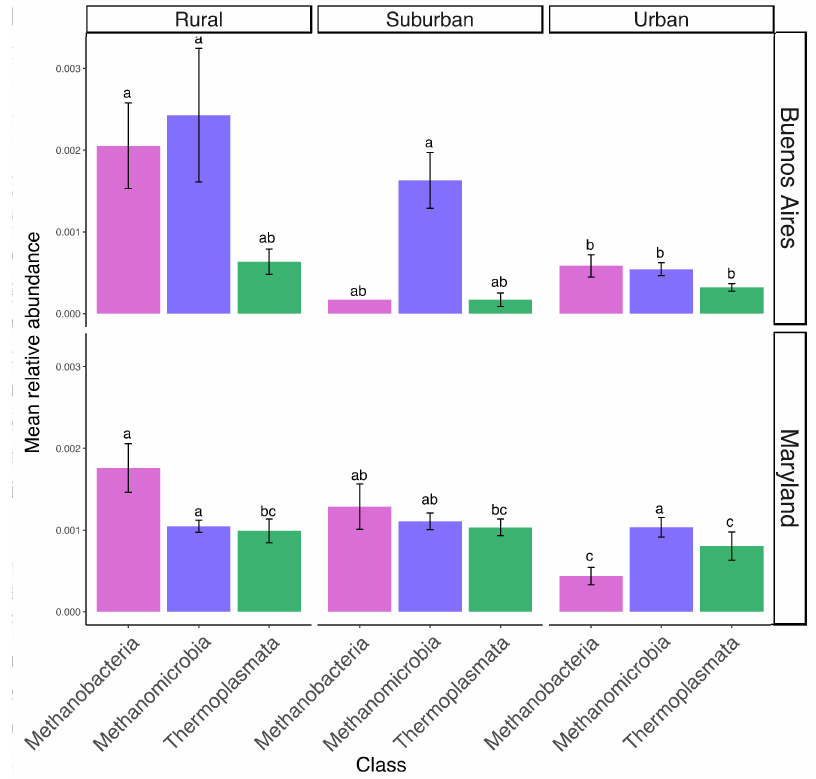
Figure 6. Mean relative abundance of Euryarchaeota classes for Buenos Aires and Washington D.C. in urban, suburban, and rural sites. Bars represent standard errors and different letters indicate significant differences between means (Tukey p < 0.05). Unclassified archaea are not included and only comprised 0.2% of total